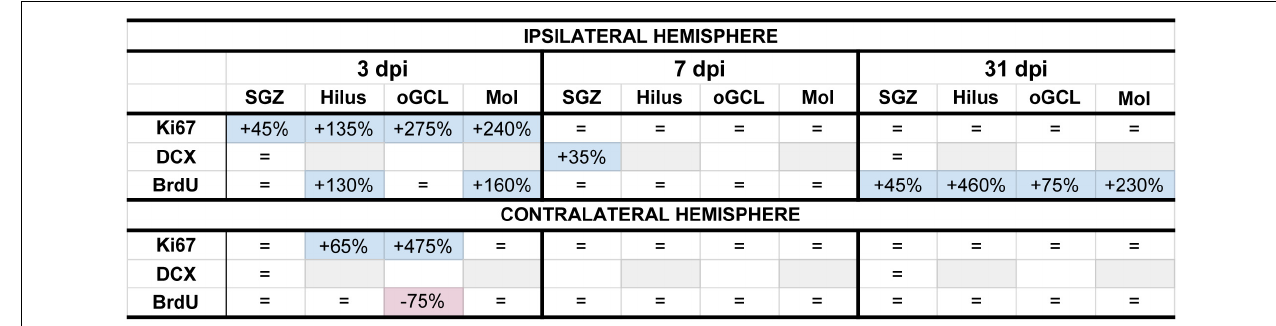
FIGURE 8 | Summary of neurogenesis changes in LFPI vs. Sham mice at three time points post-injury. Percent change in LFPI vs. Sham number of cells immunoreactive for Ki67, DCX, and BrdU in the ipsilateral (top) and contralateral (bottom) dentate gyrus (DG) subregions 3 dpi (left column), 7 dpi (middle column), and 31 dpi (right column). These summary percentages reflect data presented in Figures 2–7 and Supplementary Figures 1–6 . =, not changed vs. Sham. Light-blue shading, increased in LFPI vs. Sham. Rose shading, decreased in LFPI vs. Sham. White, not determined. Light-gray shading, not part of this